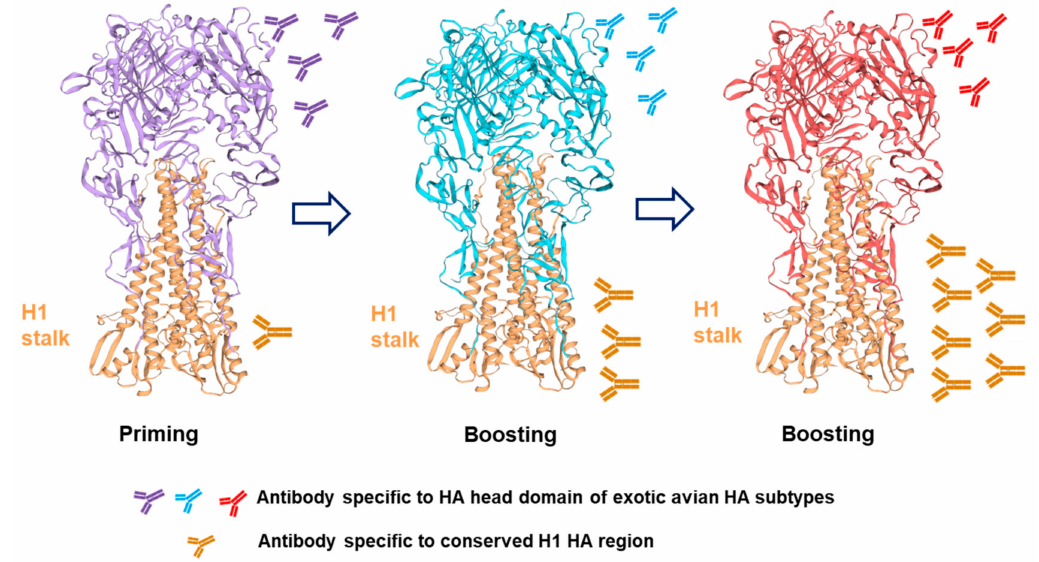
Figure 2. Chimeric HA vaccination approach. In this example, the cHA vaccine contains a stalk domain from H1 HA and head domain from an exotic avian HA subtype. Priming with the cHA induces a low antibody (Ab) response to stalk H1 HA. However, boosting with other cHAs containing the same stalk H1 HA domain with different HA head domains of exotic avian subtypes increases Ab responses to the H1 HA stalk domain. The protection conferred by the cHA is mediated by both neutralizing and non-neutralizing Abs (such as ADCC). The structure of HA was constructed using Swiss-Model (https://www.swissmodel.expasy.org/, accessed on 5 April 2021). The representative H1 HAs are from influenza A virus (A/California/07/2009(H1N1)) with sequence obtained from GenBank (ACQ55359.1) or from influenza A virus (A/goose/Guangdong/1/1996(H5N1)) with sequence obtained from GenBank